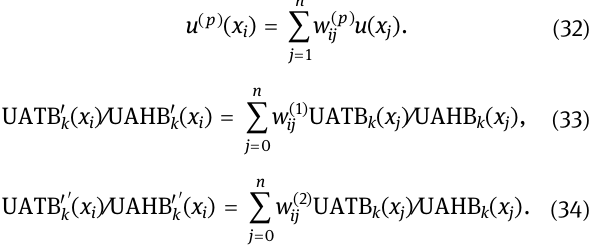
Table 21: Comparison of relative errors for = α 10 , = β 5 , = N 21 ,